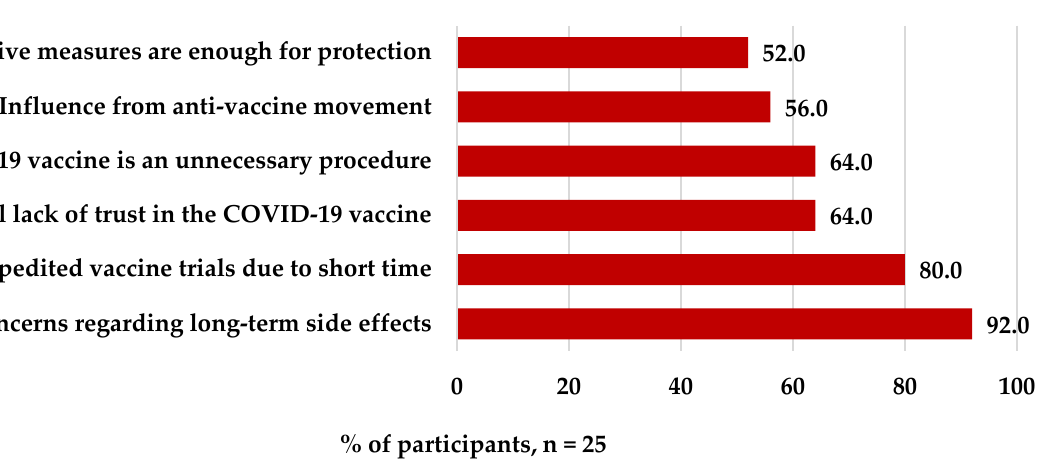
Figure 4. Motives of participants who received or wanted to receive COVID-19 vaccines. A small portion of participants (n = 25, 6.1% of the total sample) refused to receive the COVID-19 vaccine. The factors identified for their refusal included worrying about long-term side effects (92.0%) and expedited vaccine trials (80.0%). Figure 5 summarizes the factors that drove participants to decline the COVID-19 vaccines.